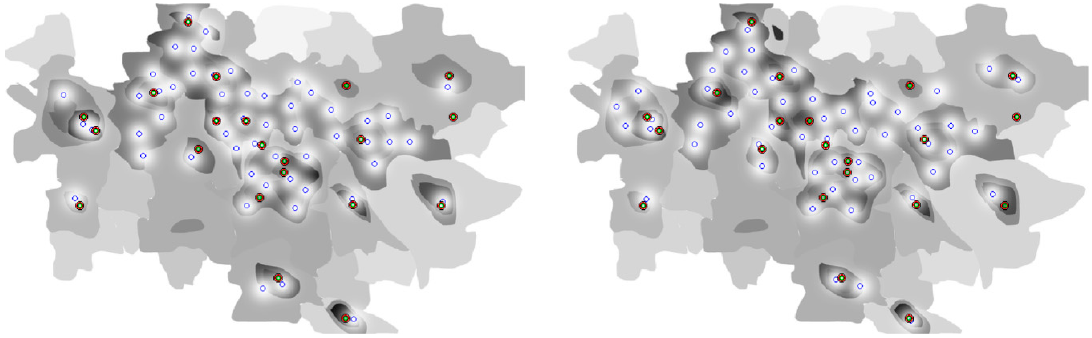
Figure 6. Examples of obtained stations layouts.